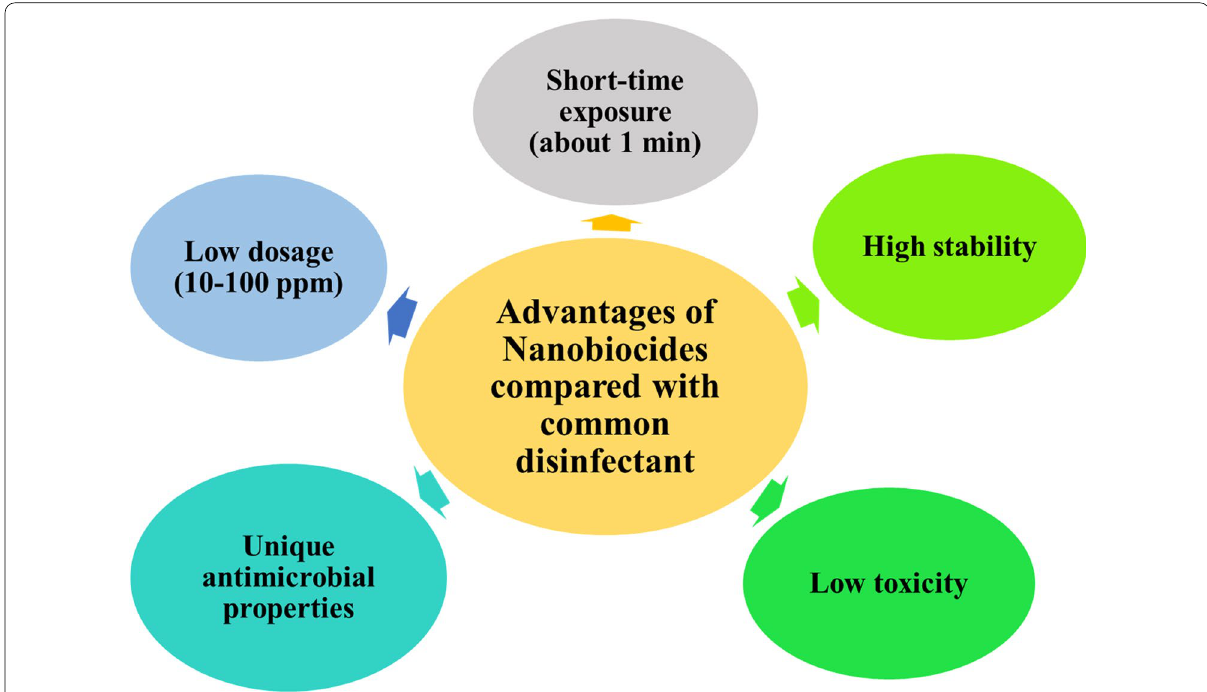
Fig. 5 An overview of nanobiocides’